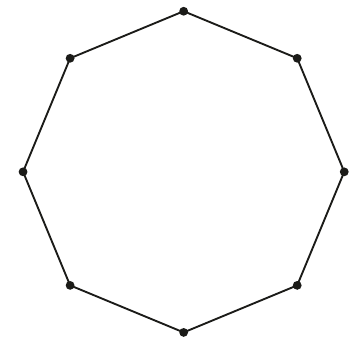
Figure 2: 𝐶 8 as an example of a cycle